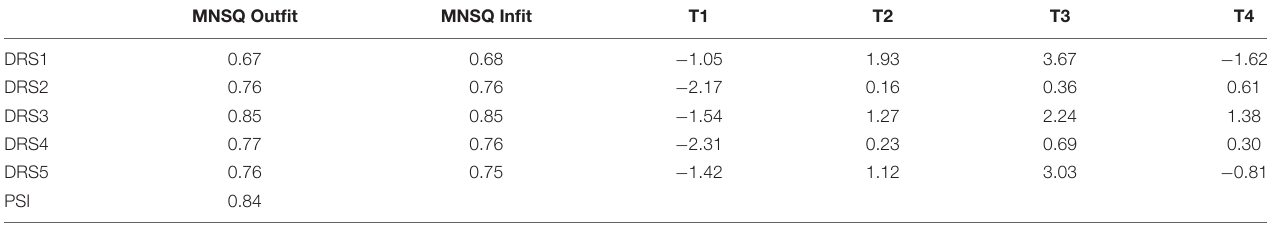
TABLE 6 | The result of PCM analysis of the DRSc.